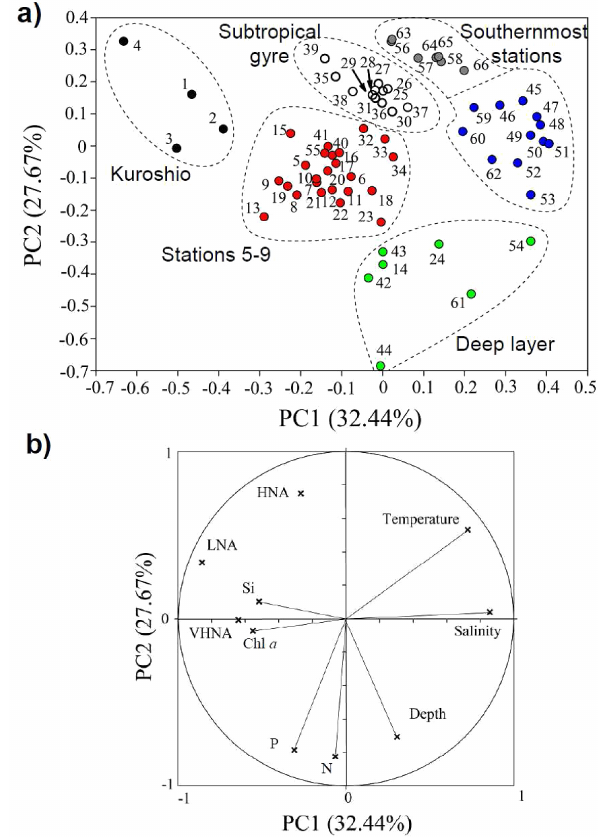
Figure 6. Hierarchical clustering illustrated for the first two princi- pal components of the principal component analysis performed with the data collected from stations 1 to 11 (a) . According to the clas- sification (Table 1) the sampling depths (numbers) were discrimi- nated into 6 clusters: one characterizes the Kuroshio region (clus- ter 1, black), another incorporates stations 5 to 9 (cluster 2, red), a third one the deep layer (cluster 3, green) and the last three clusters characterize the subtropical gyre (cluster 4, white) and the southern- most stations (5, blue and 6, dark grey). The circle (b) shows the first two dimensions of the principal component analysis. The environ- mental variables taken into consideration are temperature, salinity, depth, nitrate (N), phosphate (P), silicic acid (Si), and chlorophyll a (Chl a ).